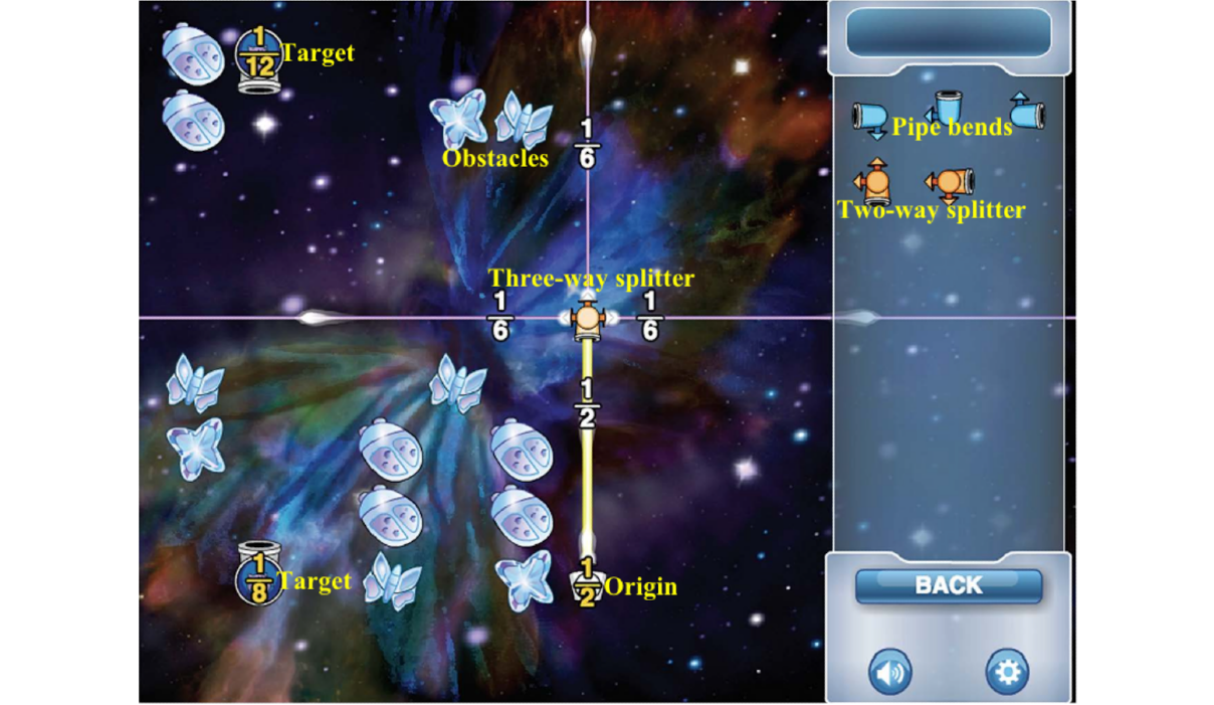
Figure 2. The Refraction EVG developed by the research group of the Center for Game Science [42,43]. The game mechanic is to use the pieces on the right to split lasers into fractional pieces and redirect them to the target spaceships.